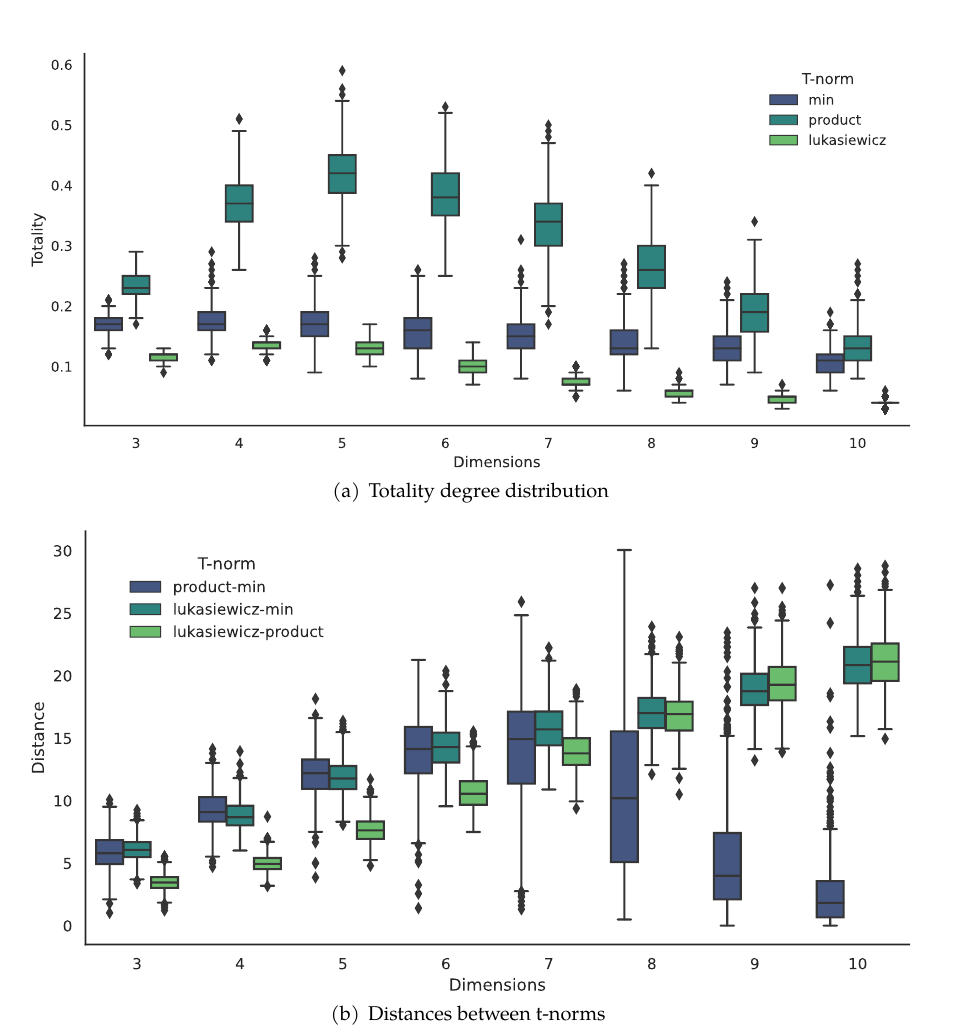
Figure 1: Metrics evaluated in the t-norm comparison. 500 iterations with 100